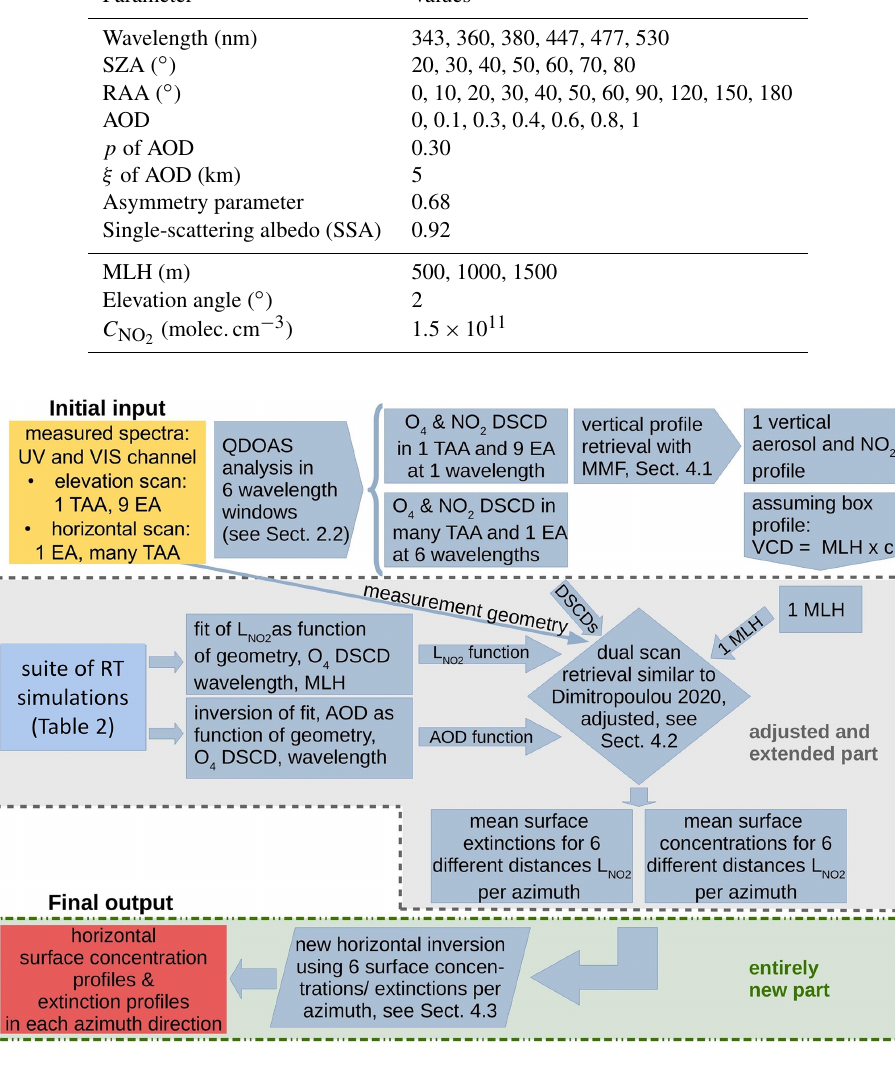
Figure 3. Mapping MAX-DOAS technique